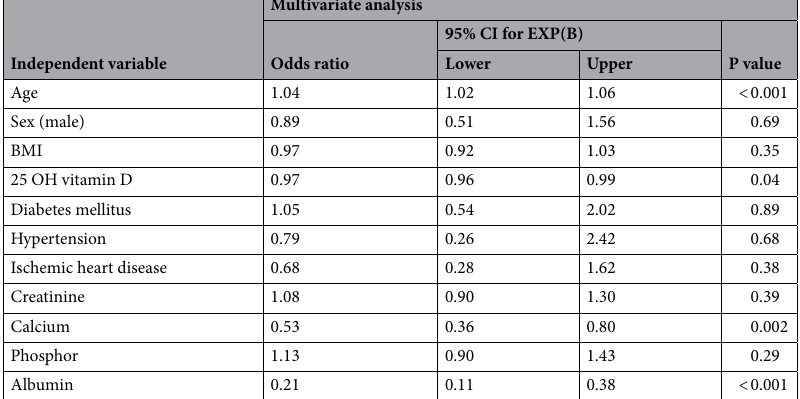
asymptomatic patients(96 vs. 33%). In patients with COVID-19 and concomitant vitamin D deficiency, and the mortality rate was 7 times (21 vs. 3%) than those with sufficient vitamin D 40 .